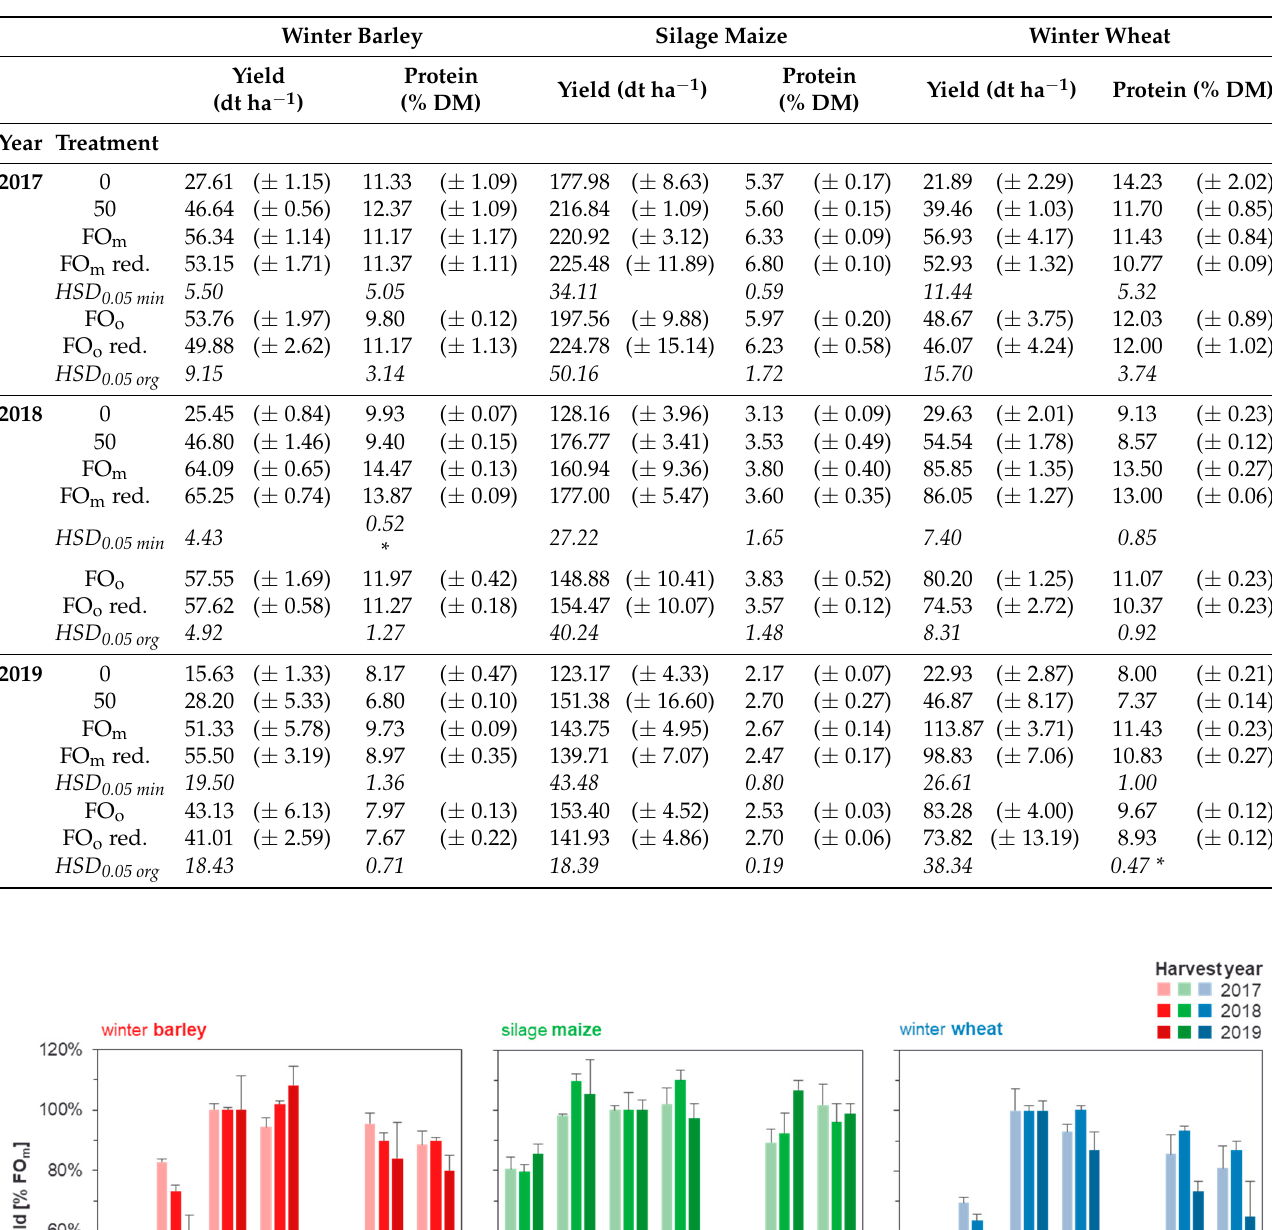
Table 3. Yield (grain yield at 86% dry matter (DM) for cereals and total DM yield for silage maize) and protein concentrations ( ± standard error) with results of Tukey-test within mineral (m) and organic + mineral (o) fertiliser treatments (HSD 0.05 ); FO: fertiliser ordinance, red: reduced; * significant.